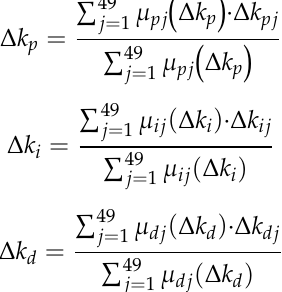
Table 1. Table of FPID mode and rule